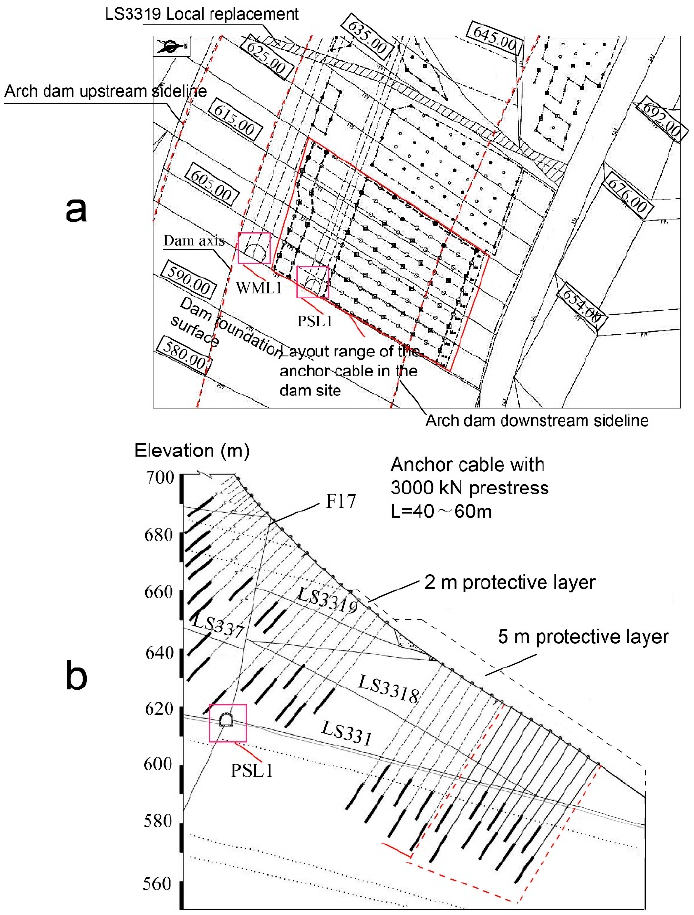
Figure 7. Dam foundation anchor support layout ( a ) elevations from 620 m to 600 m, and ( b ) profile of the arch dam downstream sideline.